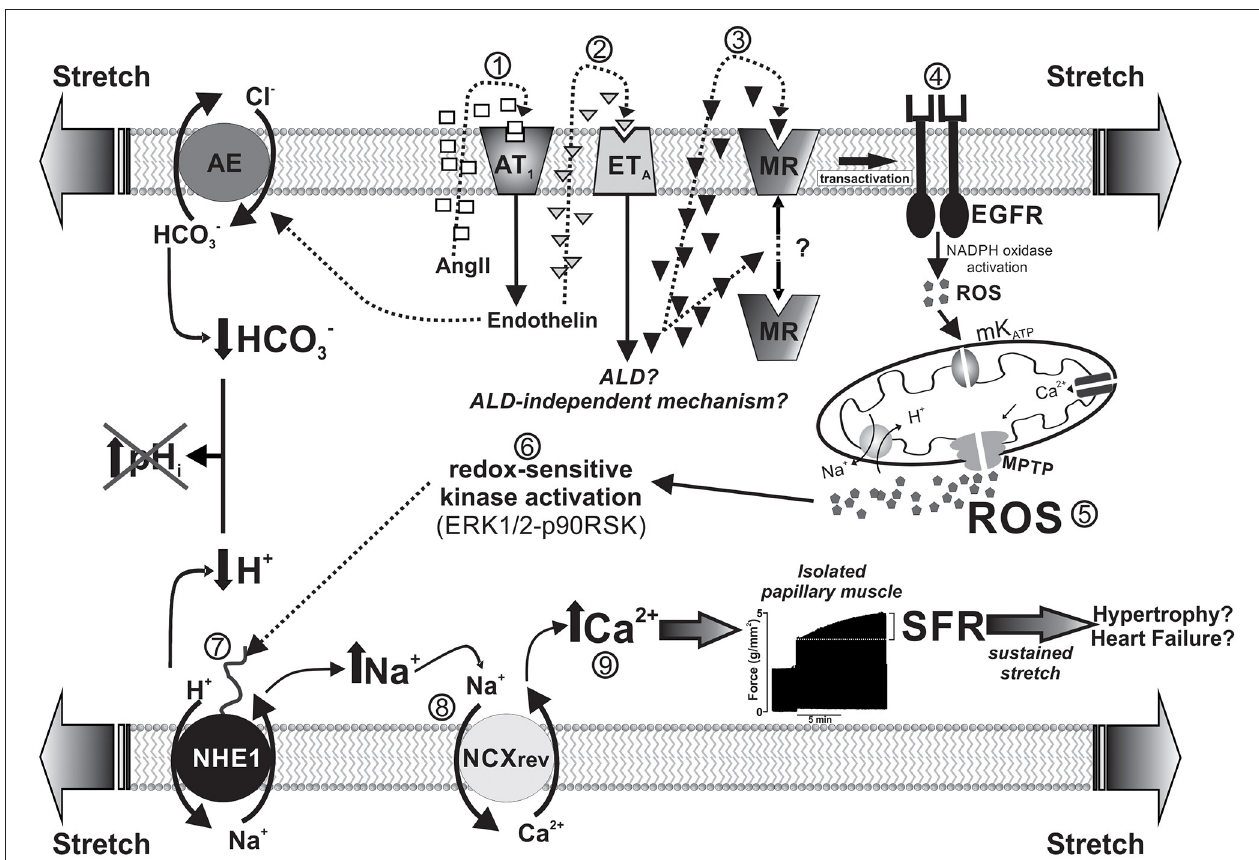
FIGURE 2 | Schematized sequence of events triggered by myocardial stretch (from “1” to “9”) leading to the SFR and eventually to cardiac hypertrophy and failure. The mechanism begins with the activation of AngII (AT1) receptors by the mechanical stimulus and is followed by a sequential activation of endothelin, mineralocorticoid, and epidermal growth factor receptors (ET A , MR, and EGFR, respectively). Downstream of EGFR, a small amount of ROS triggers a greater production/release of ROS from the mitochondria, which, in turn, leads to NHE1 stimulation through redox-sensitive kinases. NHE1 activation increases intracellular Na + and, thus, Ca 2 + transient amplitude through reverse Na + /Ca 2 + exchange (NCX rev ), leading to the SFR (represented by a typical original force record from an isolated papillary muscle suddenly stretched). Interestingly, NHE1 activation does not modify intracellular pH because of the simultaneous activation of the acidifying Cl − /HCO − 3 anion exchanger (AE) by endothelin. The idea is that this sequence of events serves in vivo to adapt cardiac force to sudden changes in hemodynamic conditions but also may conceivably lead to cardiac hypertrophy and failure if the mechanical stimulus persist on time (e.g., under conditions of arterial